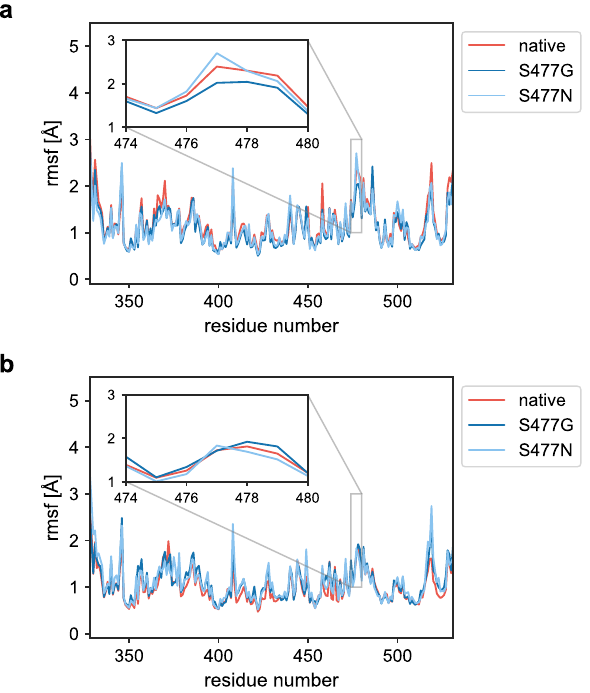
Figure 4. Comparison of residue wise root mean square fluctuations. ( a ) Unbound RDB, ( b ) in complex with hACE2. Each graph is averaged over three independent 10 ns simulations, the standard error is shown as semi- transparent bands. For clarity, values for the 10 N- and C-terminal residues of RBD are not